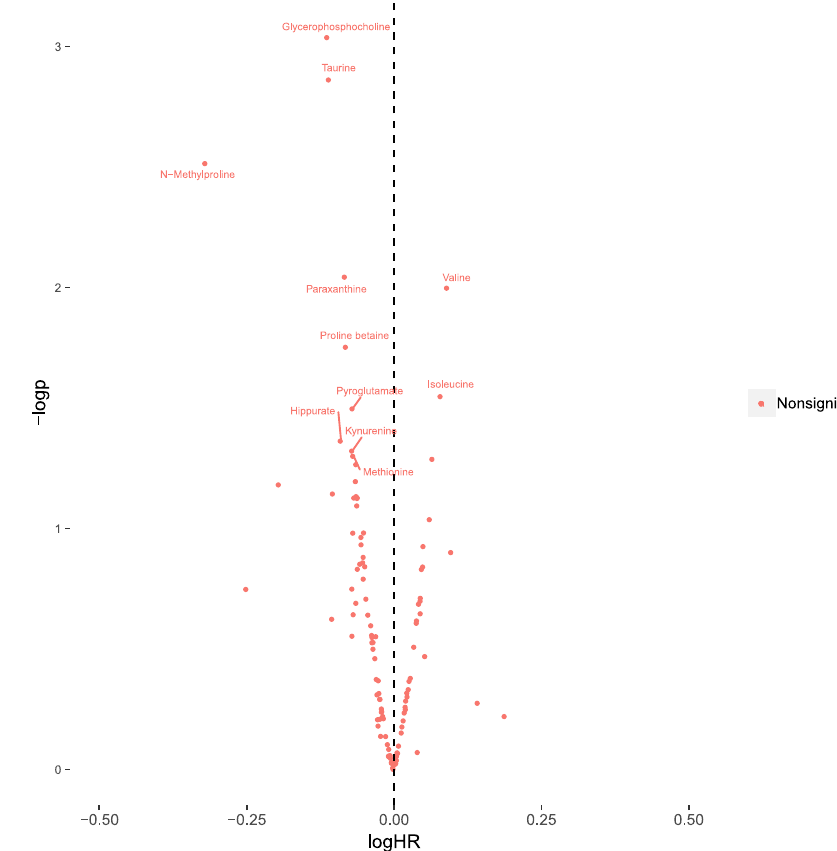
Figure 2. Associations between plasma levels of 112 metabolites and incident cardiovascular disease (CVD) in participants with diabetes from the Malmö Diet and Cancer-Cardiovascular Cohort (MDC-CC) ( n = 357) and the Malmö Preventive project (MPP) ( n = 315). The 10log hazard ratios (logHR) were calculated separately in MDC-CC and MPP from cox regression models (adjusted for age and sex) and subsequently meta-analyzed using inverse variance-weighted meta-analysis, using fixed estimates. LogHR of all-cause mortality is expressed per standard deviation increment of each metabolite. Associations were considered significant at a false-discovery rate <0.05. −logp= −10log of the p -value.